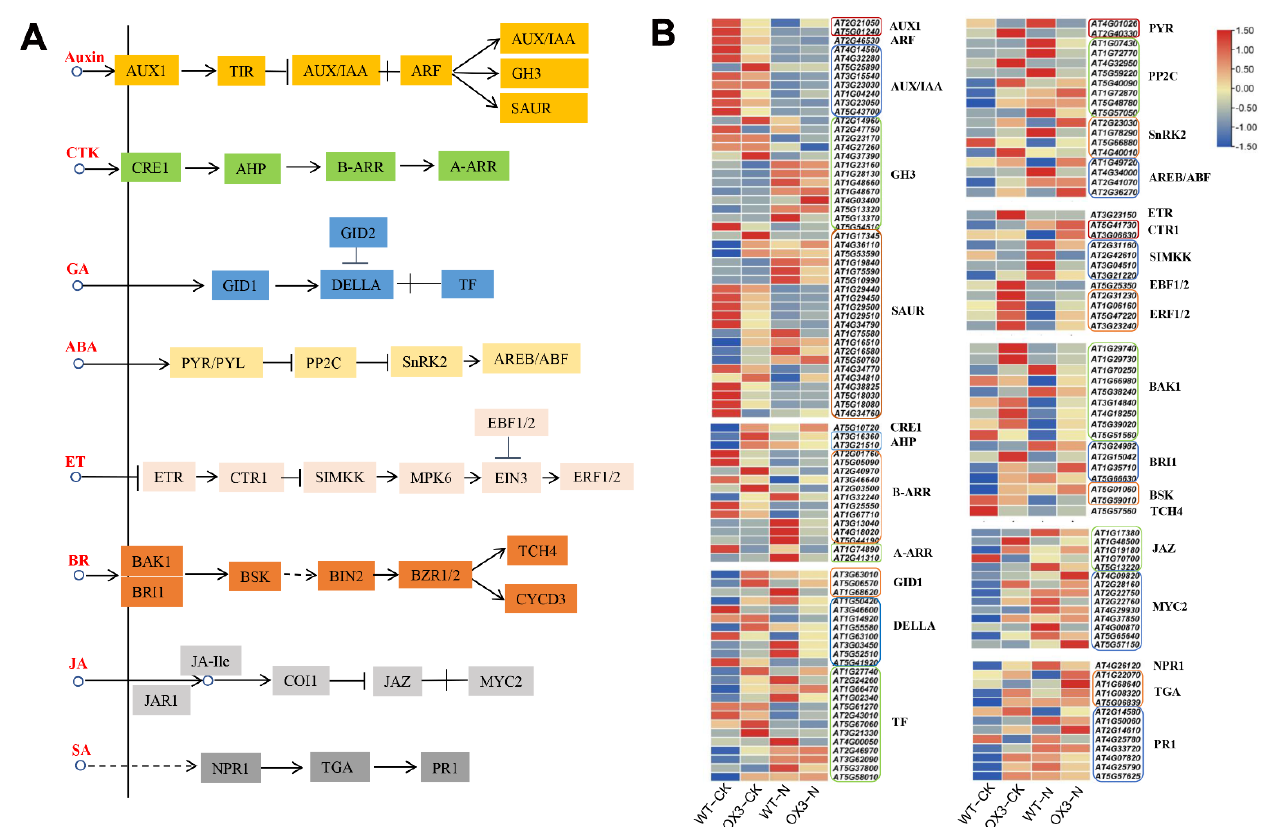
Figure 9. Transcript abundance changes of the various hormone signal transduction pathways-related DEGs in Arabidopsis wild-type (WT) and transgenic plant (OX3) under NaCl treatment. ( A ) Plant hormone signal transduction pathways. ( B ) Heat map of DEGs in various hormone signal transduction pathways. The log2-transformed FPKM values of DEGs were used to generate the